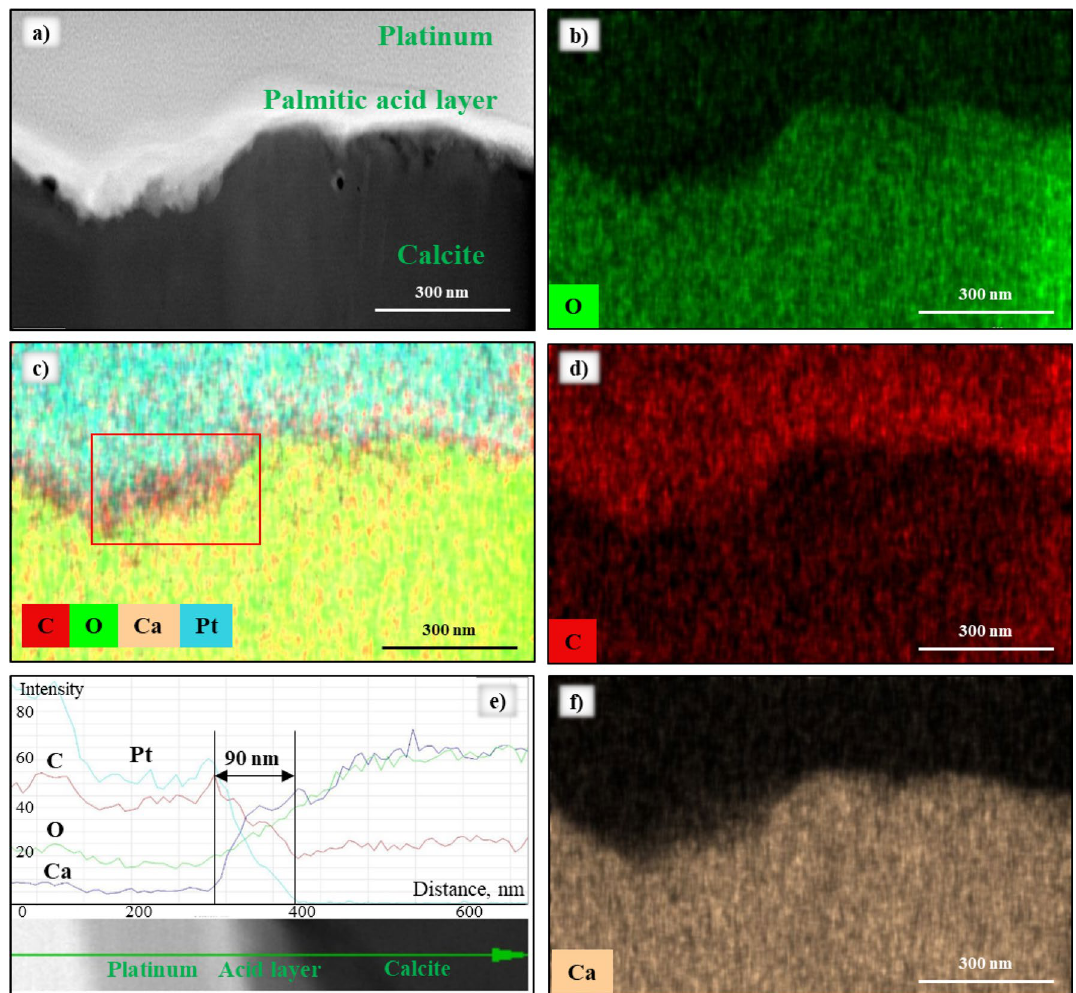
Figure 4. ( a ) HAADF-STEM image of the cross-section of the sample after aging in palmitic acid (note the platinum layer on top of the sample added for protection); ( b – d , f ) EDX mapping images illustrate distributions of all elements (C, O, Ca and Pt); ( e ) EDX signals of C, O, Ca and Pt